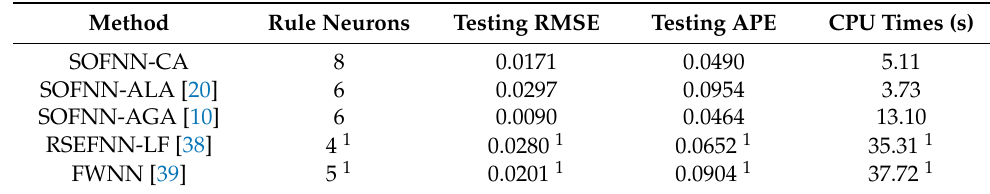
Table 2. Comparison results of different methods for identifying nonlinear system.